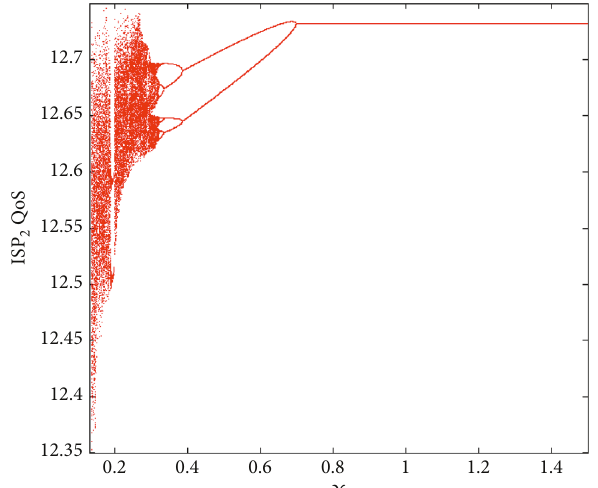
Figure 16: Bifurcation diagrams of q